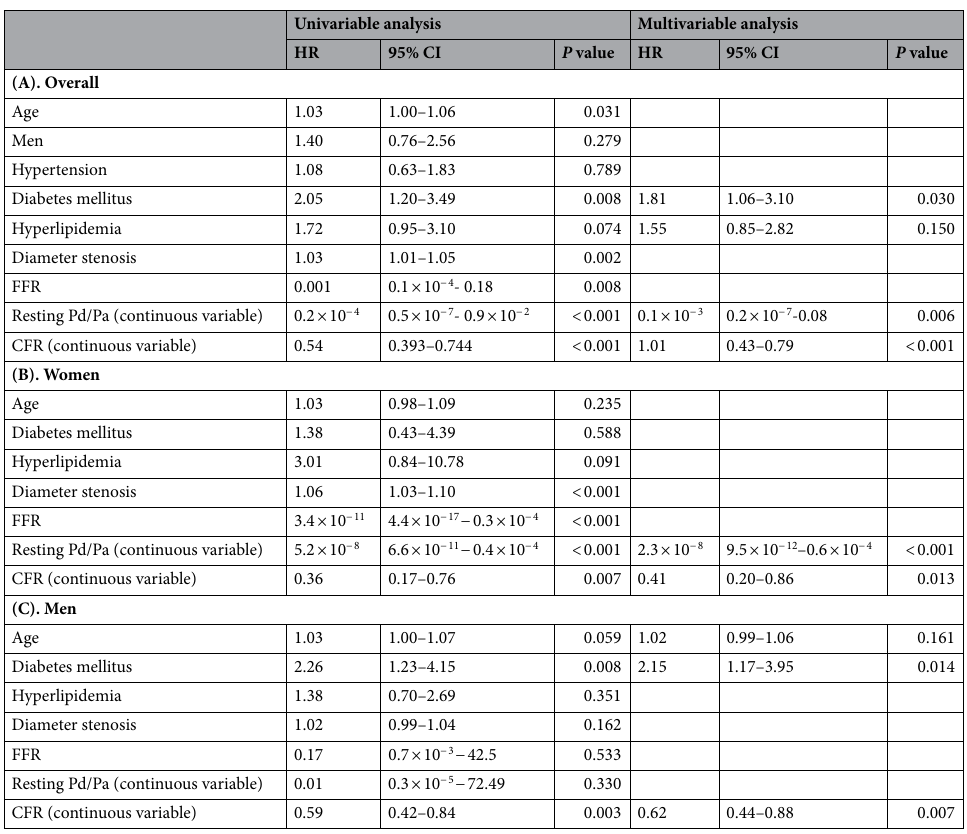
Table 2. Univariate and multivariate cox regression analysis of predicting 2-year TVF. TVF Target vessel failure, FFR Fractional flow reserve, CFR Coronary flow reserve; HR Hazard ratio; CI Confidence interval.